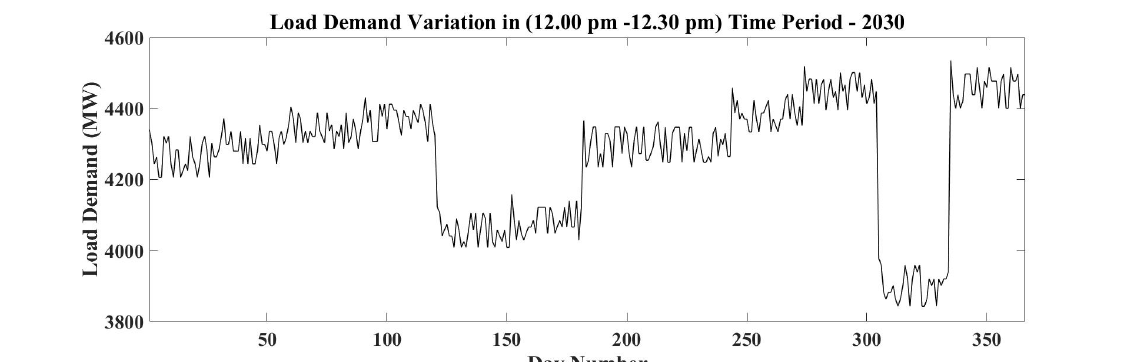
Figure 6 : Load Demand Variation in 2030.